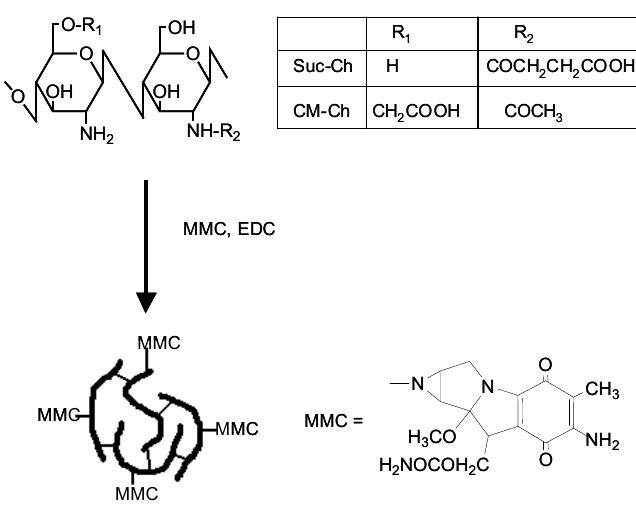
Figure 2. Preparation and structural features of N -succinyl-chitosan-MMC conjugate microparticles (Suc-Ch-MMC) and 6- O -carboxymethylchitin-MMC conjugate microparticles